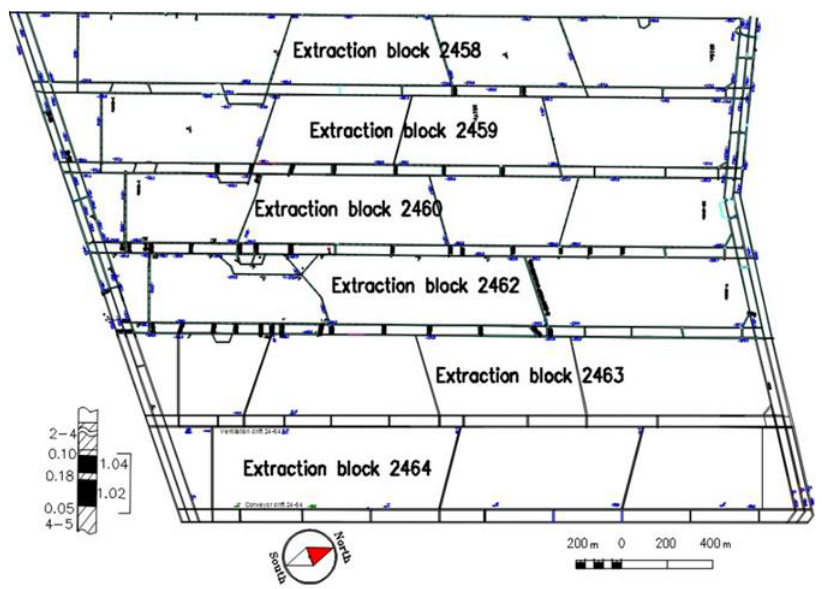
Figure 1. Mine workings layout in Boldyrevsky Seam.